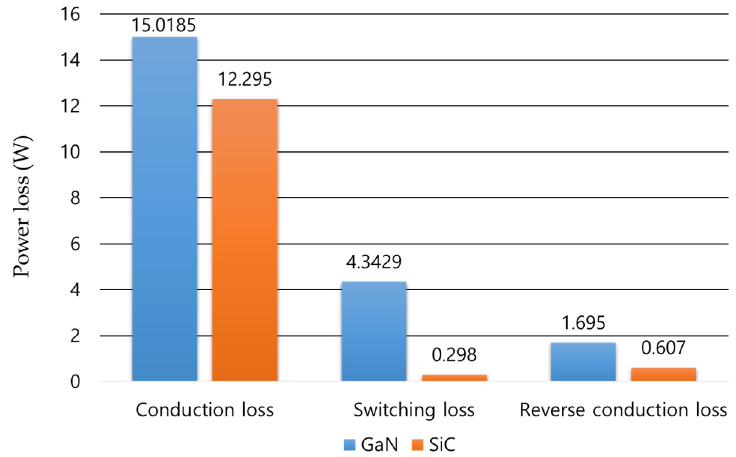
Figure 10. Loss breakdown reflecting experimental values at 2 kW.